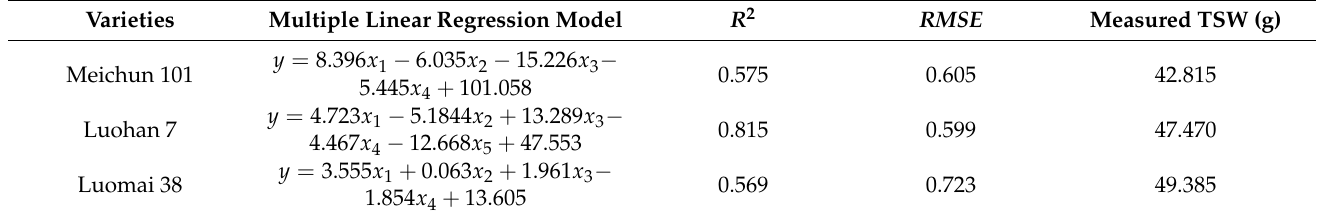
Table 4. Multiple linear regression models for the thousand seed weight of wheat seeds of three different